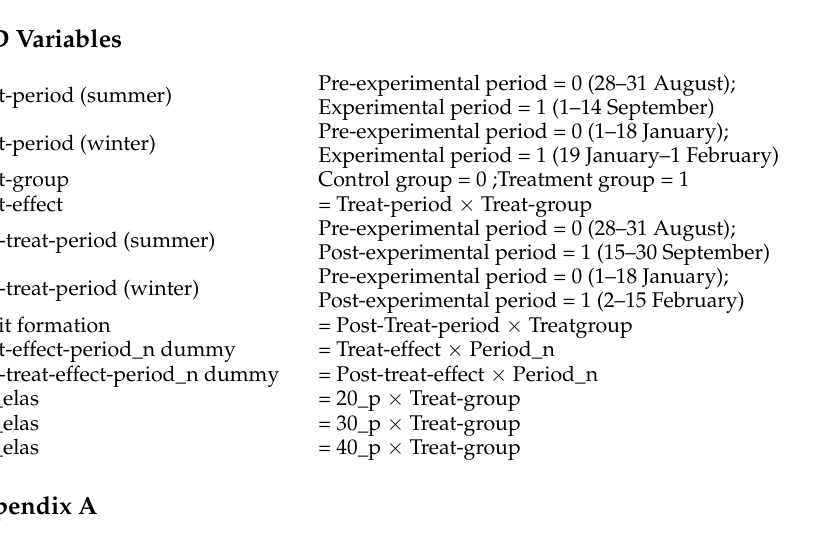
Table A1. Full regression results of the summer’s